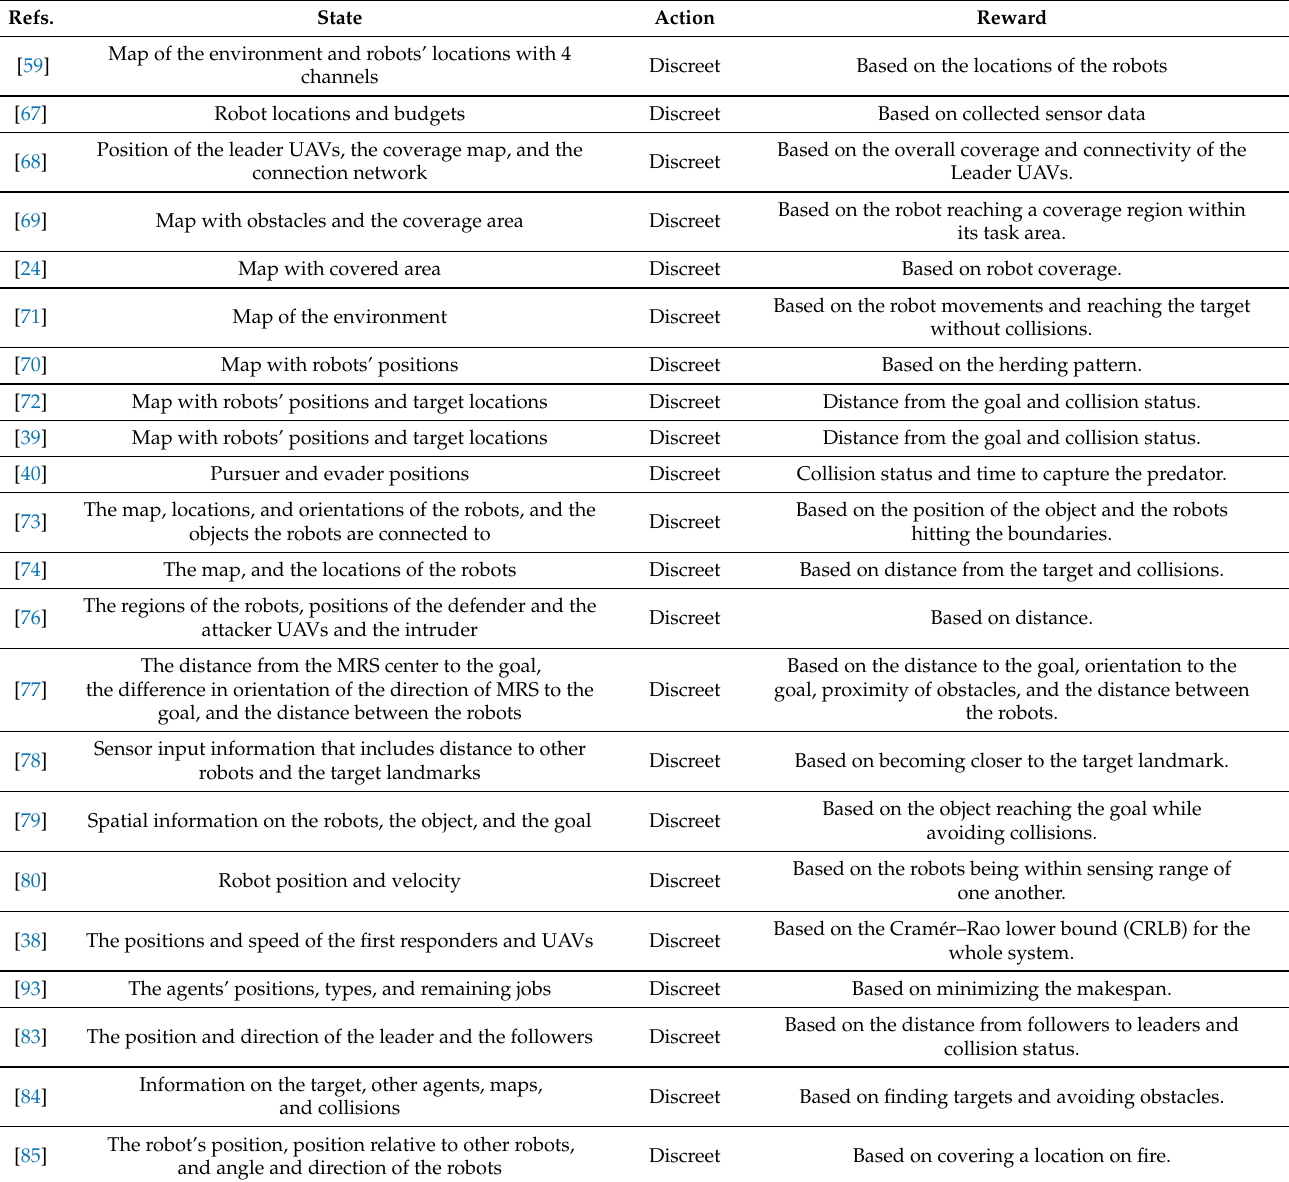
Table 2. Examples of state and action spaces and reward functions used in prior